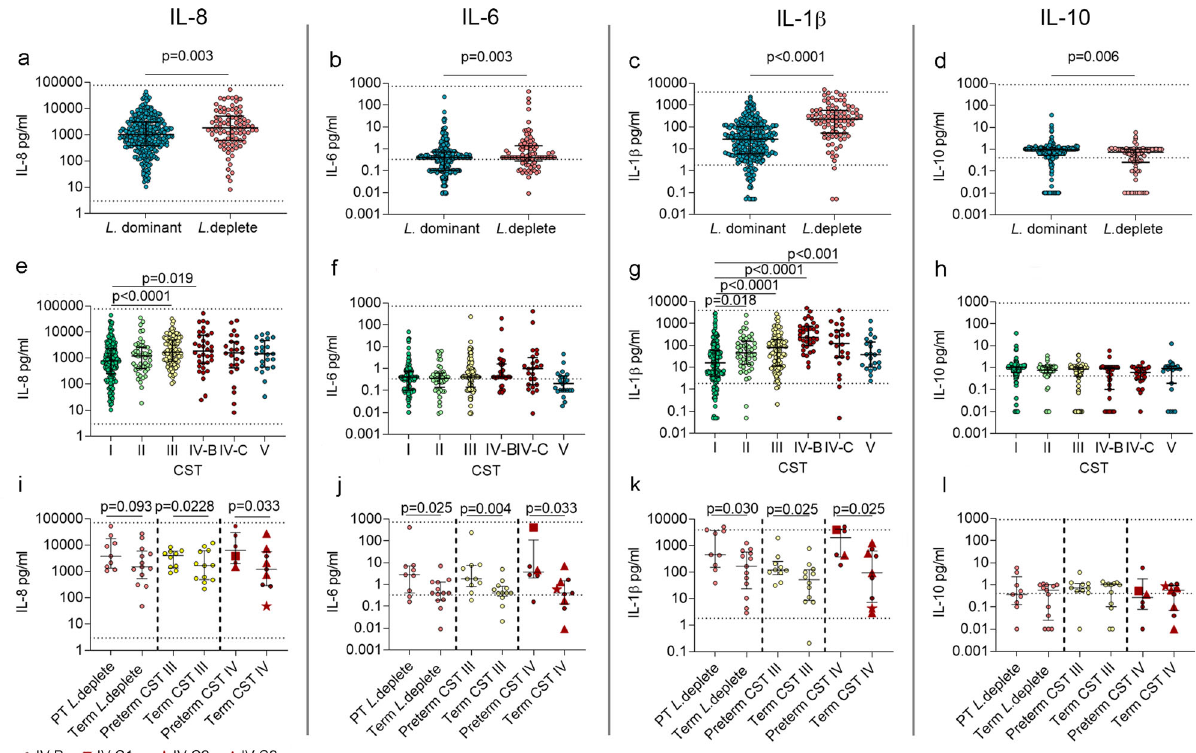
Fig. 3 Cervicovaginal microbial composition modulates the local cytokines and leads to a pro-in fl ammatory response in women who deliver preterm. Cervicovaginal concentrations of IL-8 ( a ), IL-6 ( b ), IL-1 β ( c ), and IL-10 ( d ) are shown from samples classed as Lactobacillus dominant or deplete, n = 385 samples, n = 133 women. Statistical analysis was performed using a one-sided Mann – Whitney test. Cervicovaginal cytokine concentrations of IL-8 ( e ), IL-6 ( f ), IL-1 β ( g ), and IL-10 ( h ), are shown relating to samples taken from a vaginal composition classed as CST I, II, III, IV-B, IV-C and V, n = 385 samples, n = 133 women. Statistical analysis was performed using the Kruskal – Wallis and Dunn ’ s multiple comparison ’ s test. Cervicovaginal concentrations of IL-8 ( i ), IL-6 ( j ), IL-1 β ( k ), and IL-10 ( l ) were compared between women who delivered preterm or at term in those who were classed as being Lactobacillus deplete ( n = 22), or abundant in CST III ( L. iners ) ( n = 22) or CST IV (diverse) ( n = 15). CST IV was subdivided into CST IV-B ( n =